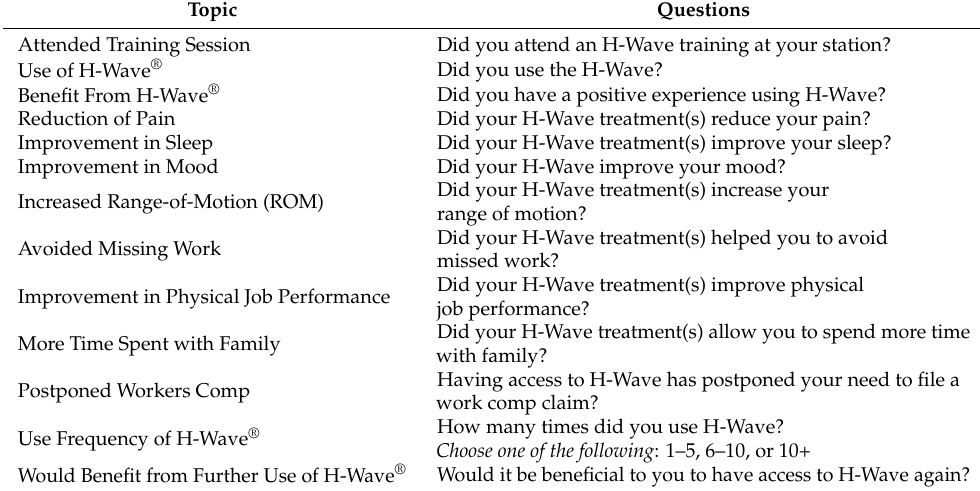
Table A1. Survey